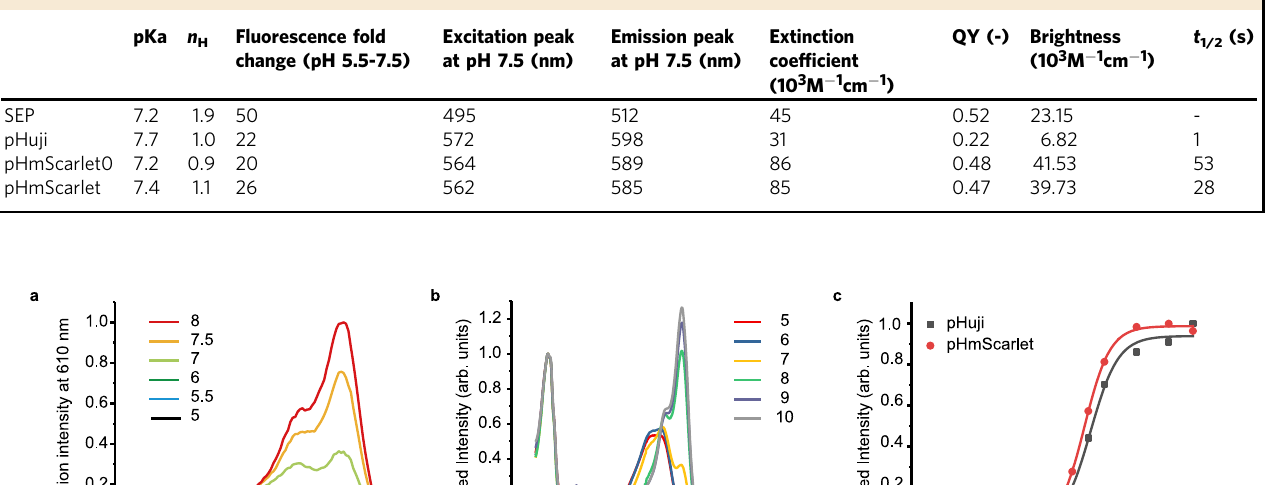
Table 1 In vitro characterization of pH-sensitive FPs.